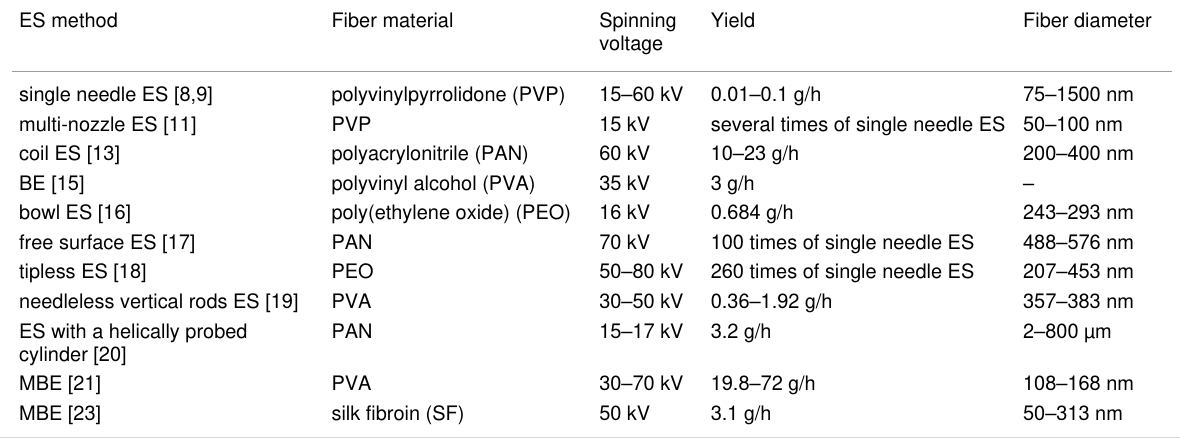
Table 1: The spinning parameters and yields of the established electrospinning (ES) techniques. Modified bubble electrospinning (MBE); bubble elec- trospinning (BE). ES